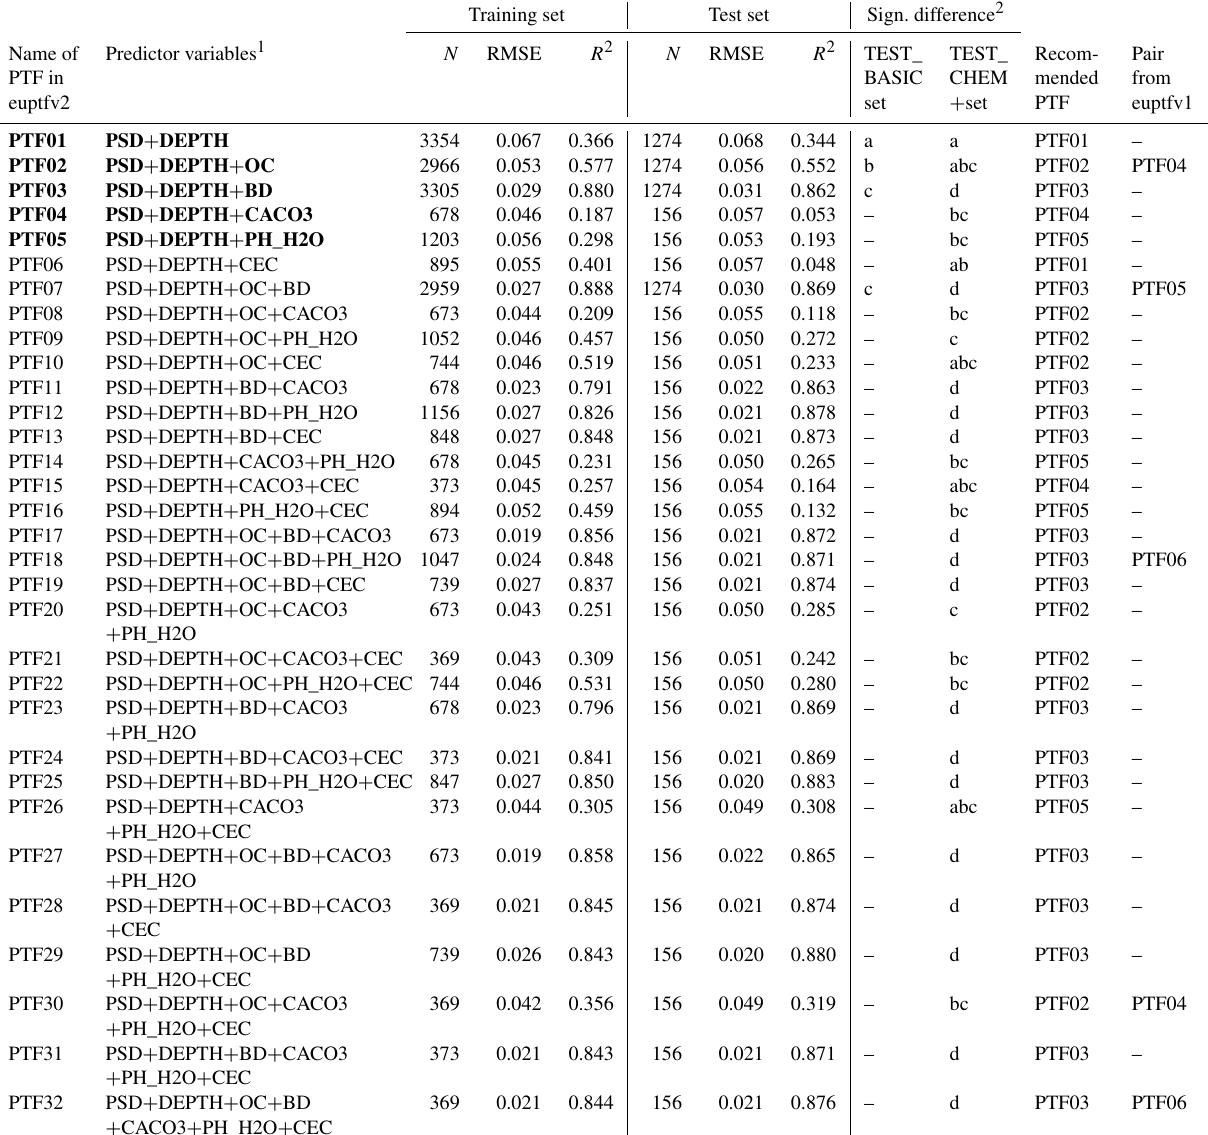
Table 2. Performance of pedotransfer functions (PTFs) by input combination on training and test datasets to predict water content at saturation (THS). N : number of samples, RMSE: root mean square error (cm 3 cm − 3 ), and R 2 : determination coefficient, TEST_BASIC: samples with measured PSD, DEPTH, OC and BD; TEST_CHEM + : samples with measured PSD, DEPTH, OC, BD, CACO3, PH_H2O and CEC. Recommended PTFs are highlighted in